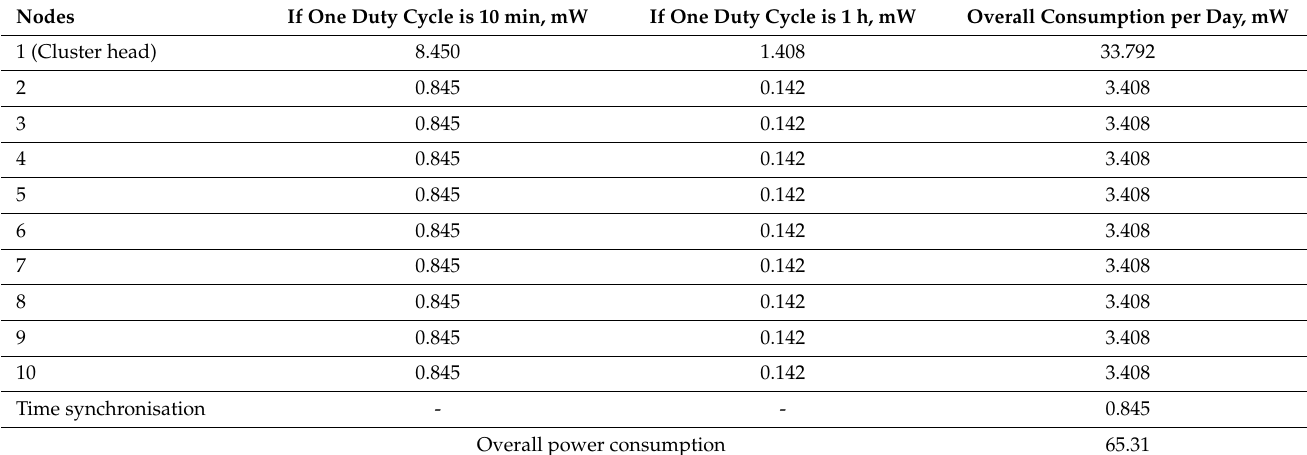
Table 2. Power consumption of sensor